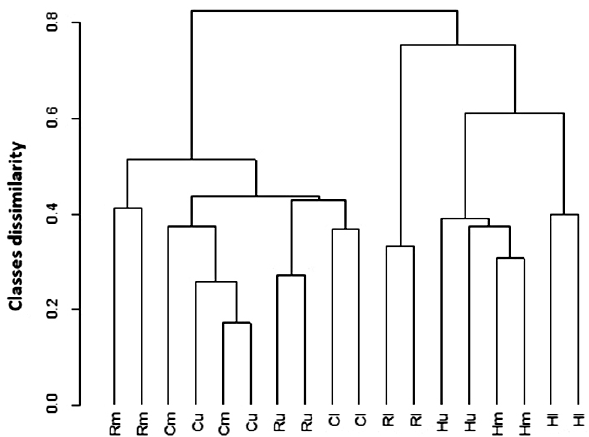
Figure 4. Cluster analysis of the SSCP bands observed on SSCP profiles of soil sampled from the columns C (uncontaminated soil), H (contaminated by the raw waste containing oily compounds and radionuclides), and R (contaminated by treated waste containing mainly radionuclides) in different layers [upper (0–20cm; u ), mid- dle (20–40cm; m ), and lower (40–60cm; l )].